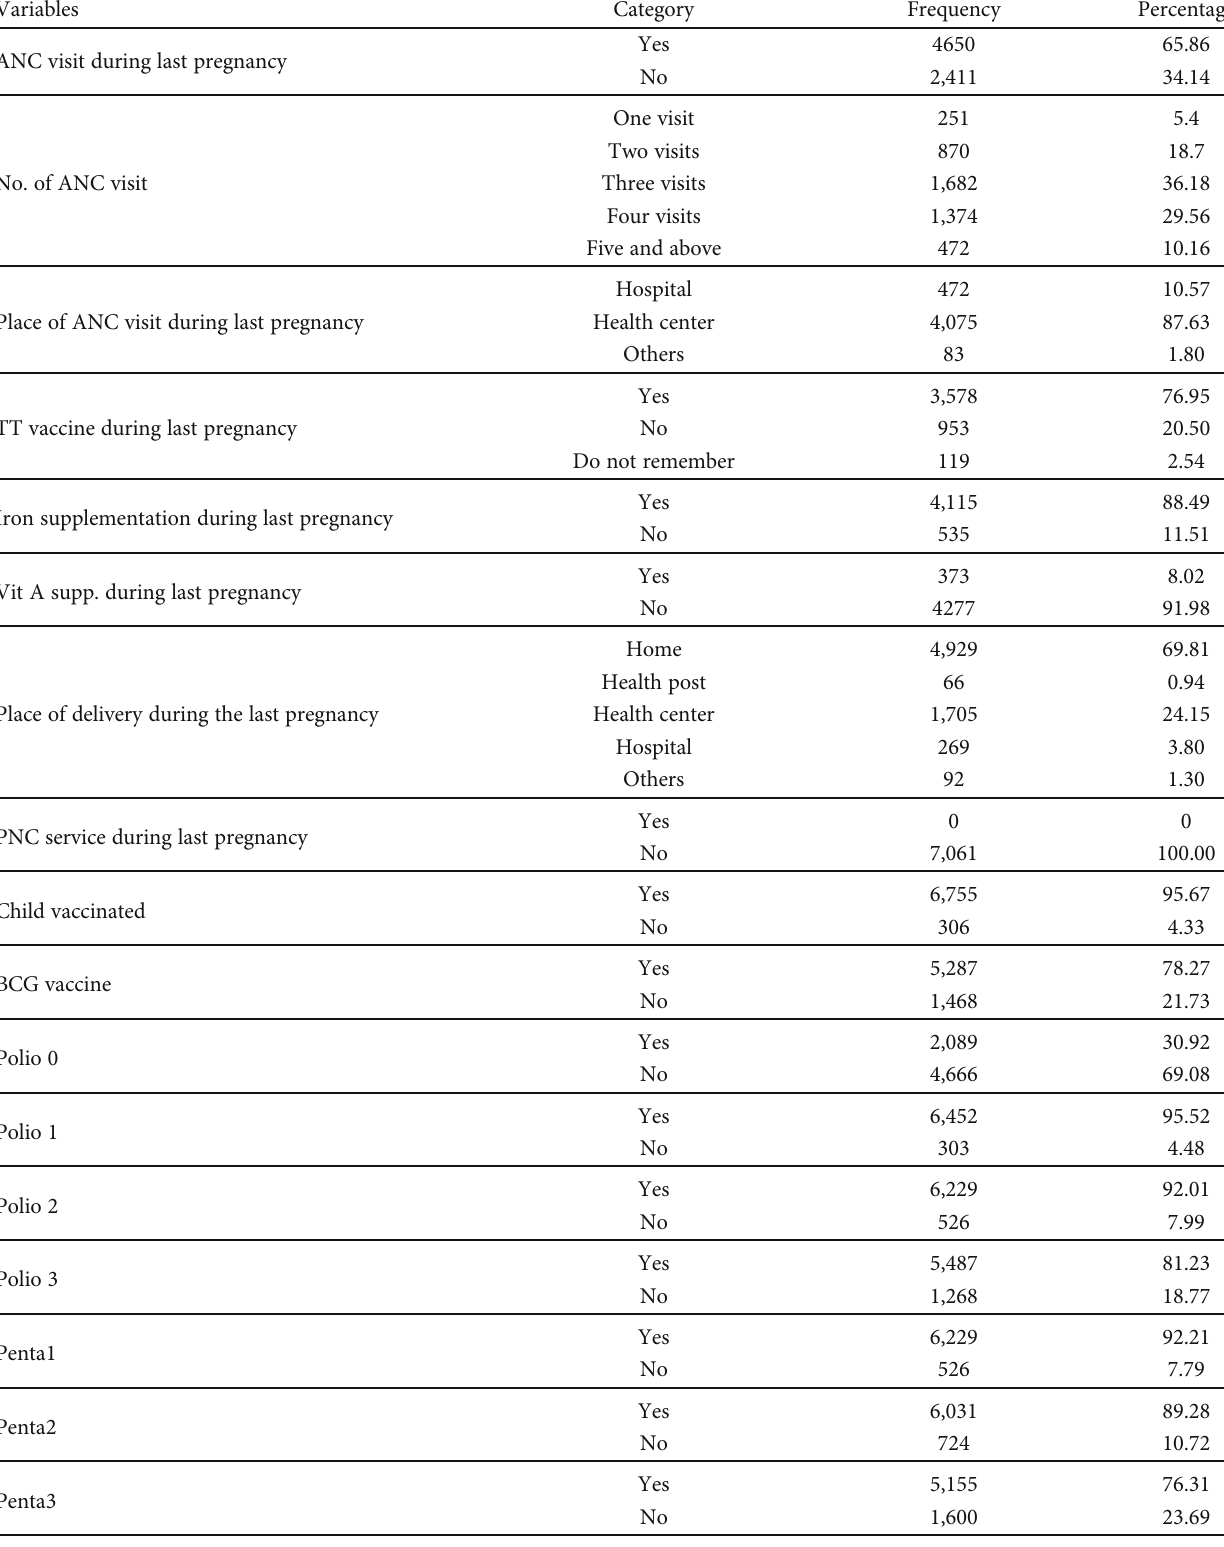
Table 2: Maternal and child health service utilization and child feeding practice in Dabat HDSS site, Dabat district, North West Ethiopia: April